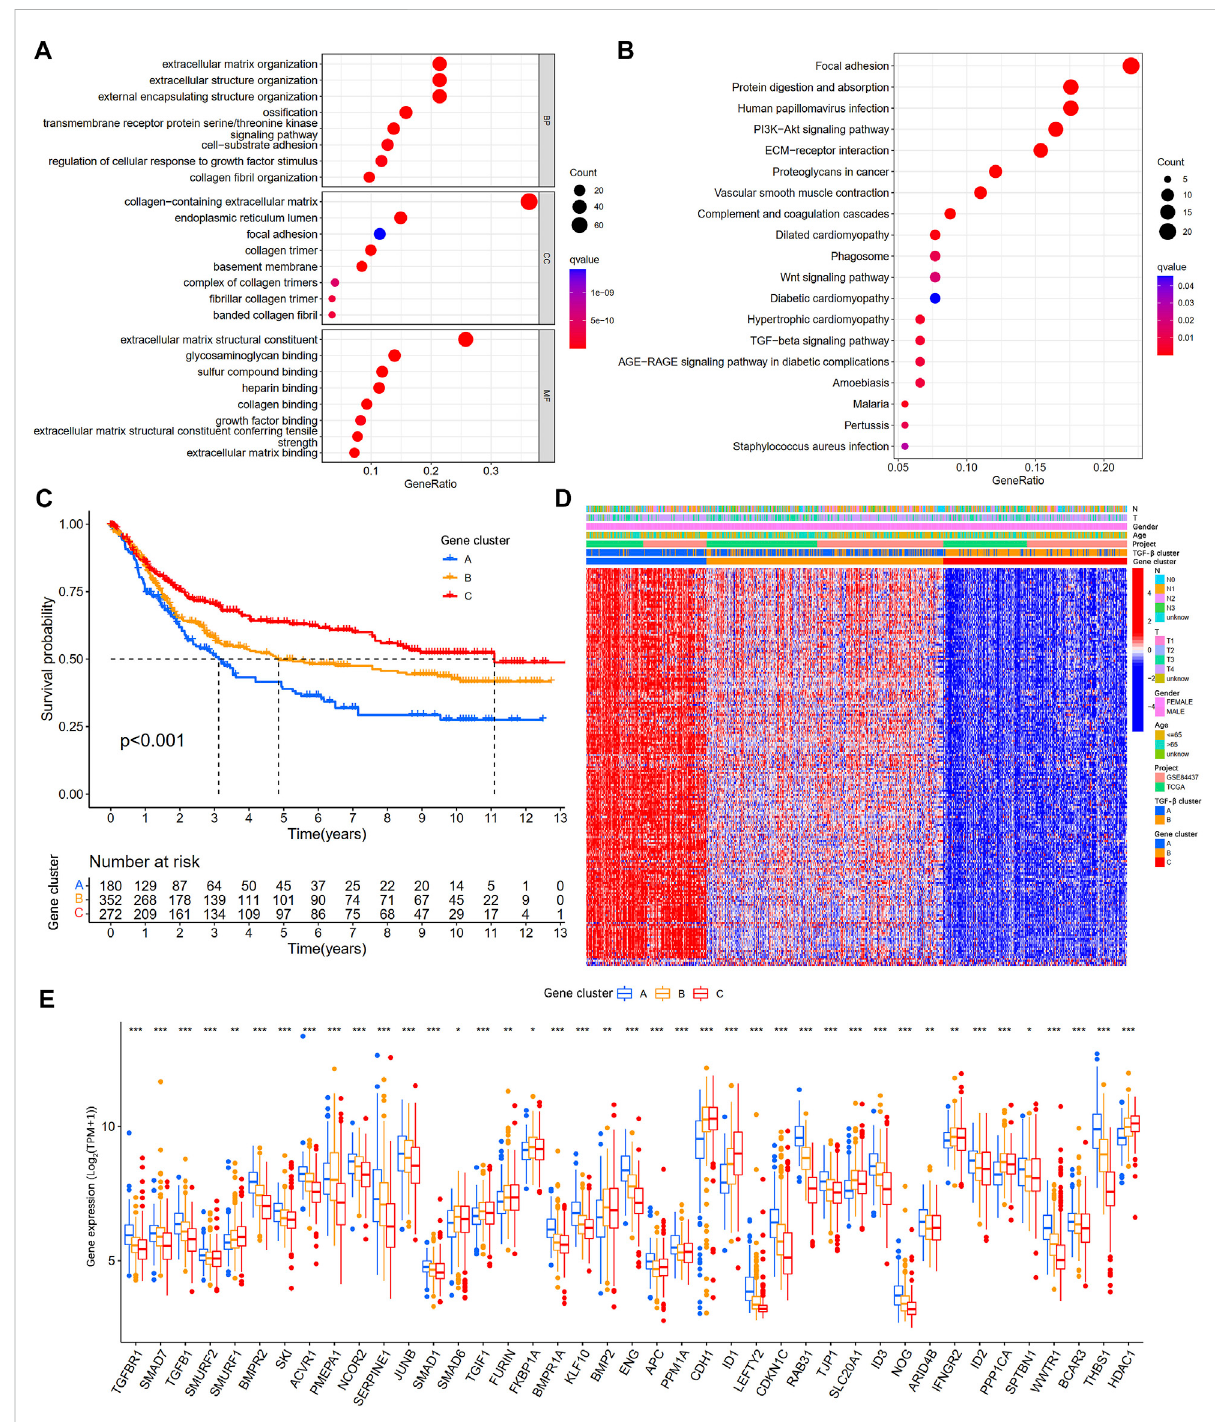
FIGURE 4 Identi fi cation of gene subgroups based on DEGs among two TGF- β subgroups. (A,B) GO and KEGG enrichment analyses of DEGs among two TGF- β subgroups. (C) Kaplan-Meier survival analysis between three different gene subgroups. (D) Heatmap of clinicopathologic characteristics and DEGs expressions among the three gene subgroups. (E) Differences in the expression of 54 TSRGs among the three gene subgroups. DEGs, differentiallyexpressedgenes; GO, GeneOntology; KEGG, Kyoto EncyclopediaofGenesandGenomes; TSRGs, TGF- β signaling related genes; *p < 0.05; **p < 0.01; ***p <